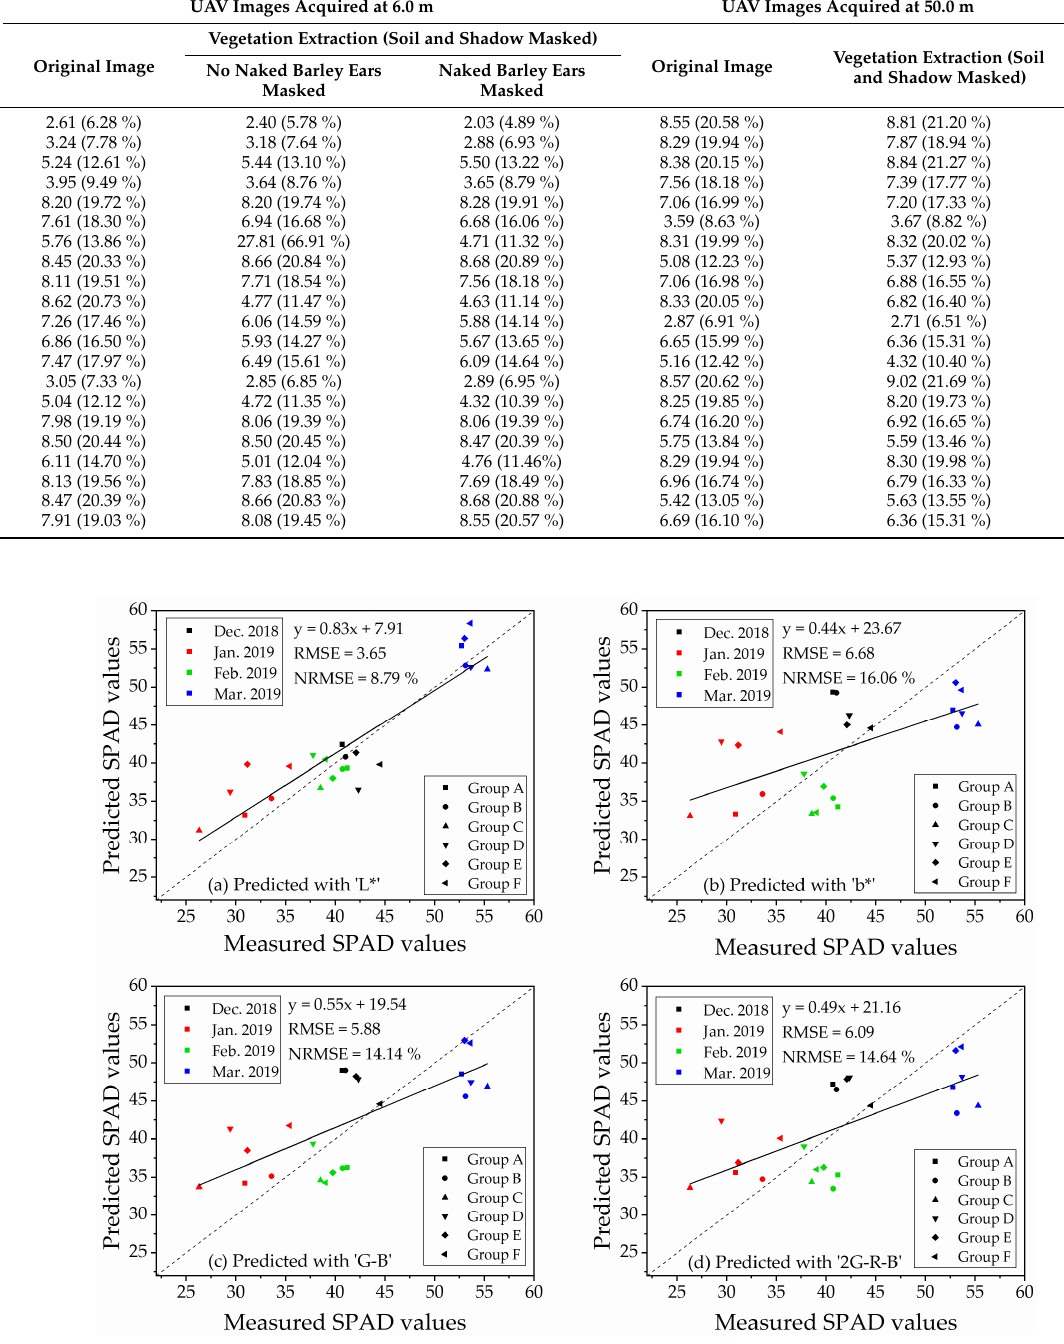
Figure 10. Validation of the four models for estimating of SPAD values at the flight height of 50.0 m (n = 23).